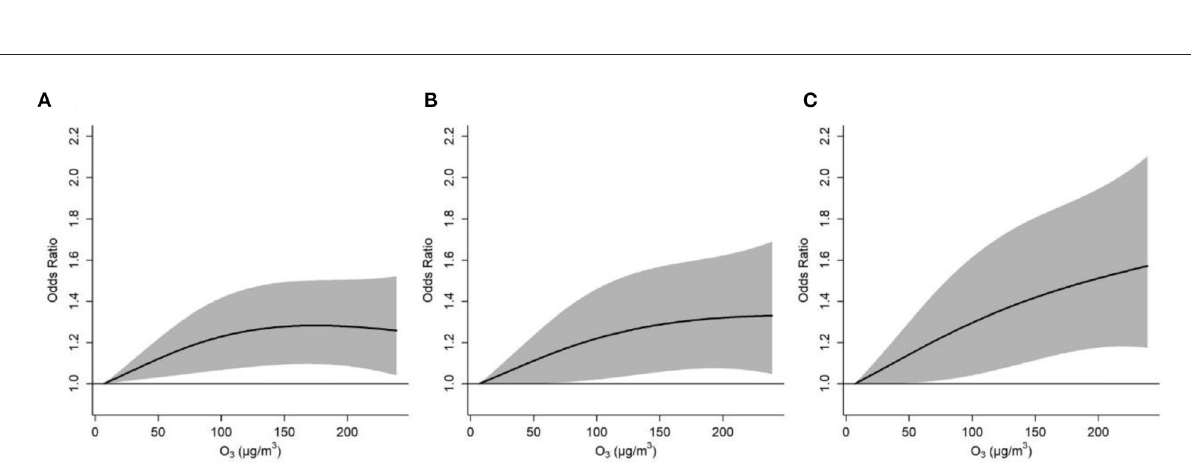
FIGURE3 Cumulative exposure-response curves for the associations between ozone concentration and asthma exacerbations defined by diurnal peak expiratory flow variation over 10% (A) , 15% (B) , and 20% (C) , over lag 0–2 days. The solid lines and shaded areas represent odds ratios and the 95% confidence intervals,